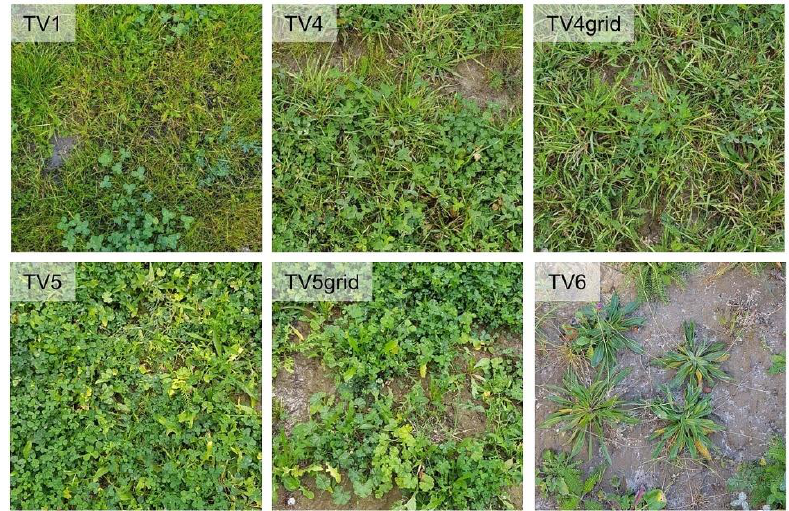
Figure 1. Test vegetations prior to testing in autumn 2018 (see also [44]). TV1 = species‐poor grass‐ dominated mixture, TV4 = grass-herb mixture, TV5 = species‐rich herb‐dominated EcoDike mixture, grass-dominated mixture, TV4 = grass-herb mixture, TV5 = species-rich herb-dominated EcoDike TV6 = species-rich herb-dominated ready-mix, and grid = geogrid reinforcement. mixture, TV6 = species-rich herb-dominated ready-mix, and grid = geogrid